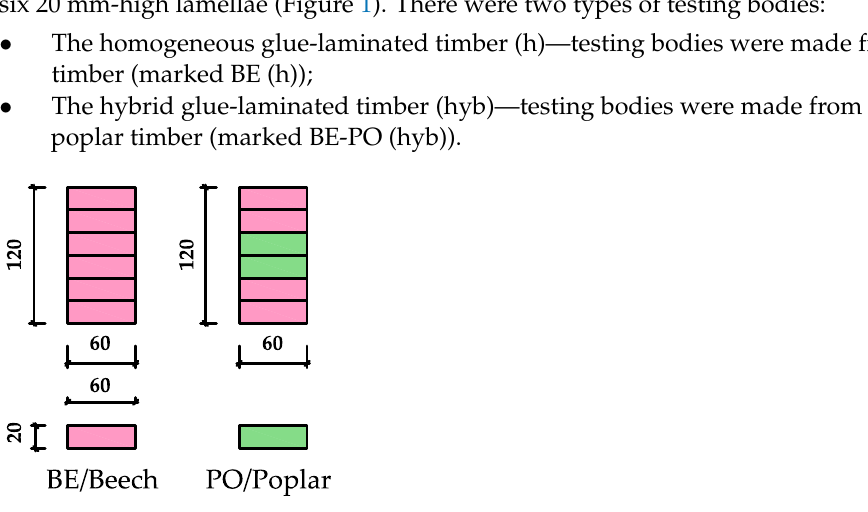
Figure 1. Tested samples GLT: BE = beech, PO = poplar. Dimensions in mm.